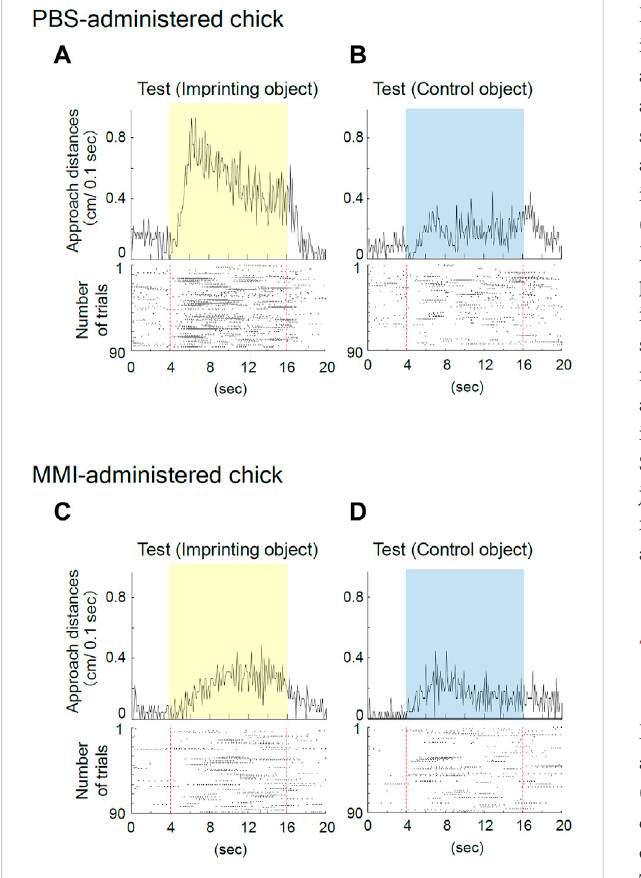
FIGURE 5 Representative behavior of phosphate-buffered saline (PBS)- administered and methimazole (MMI)-administered chicks during imprintingtest. (A) Averagedapproachdistanceandrasterplotsforthe imprinting object trials in the test of the PBS-administered chick are shown. The chick constantly responded to the static state of the object. (B) The PBS-administered chick responded to the control object, but the responses were small. (C) The MMI-administered chicks responded weakly to the imprinting object. (D) The MMI- administeredchickrespondedslightlytothecontrolobjectastheydid to the imprinting